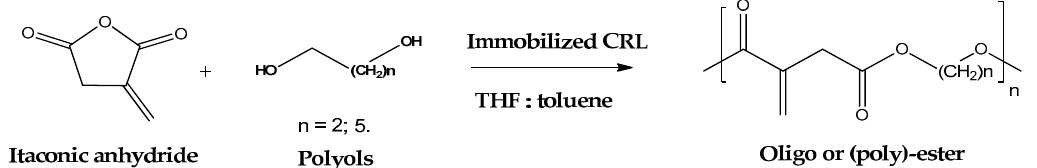
Figure 7. Activation of chitosan using the bifunctional reagent glutaraldehyde. ( A ) Classical methodology for derivatizing the primary amino groups of chitosan using glutaraldehyde as a crosslinking agent. ( B ) Preparation of supports based on chitosan activated with glycidol, ethylenediamine, and glutaraldehyde [64].